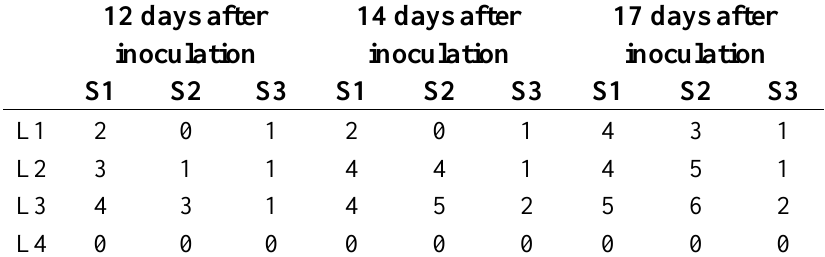
Table 1. Symptom assessment of three scab inoculated leaves with different levels of symptoms (L1–L3) and one control leaf (L4) based on the Chevalier scale (S1; 0–5 scale), sporulation scale (S2; 0–7 scale) and chlorosis scale (S3; 0–4 scale).